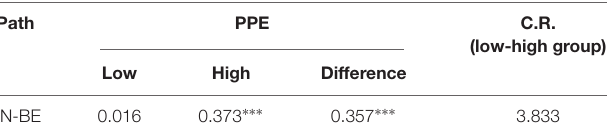
TABLE 6 | Multi-group analysis across the low and high group of